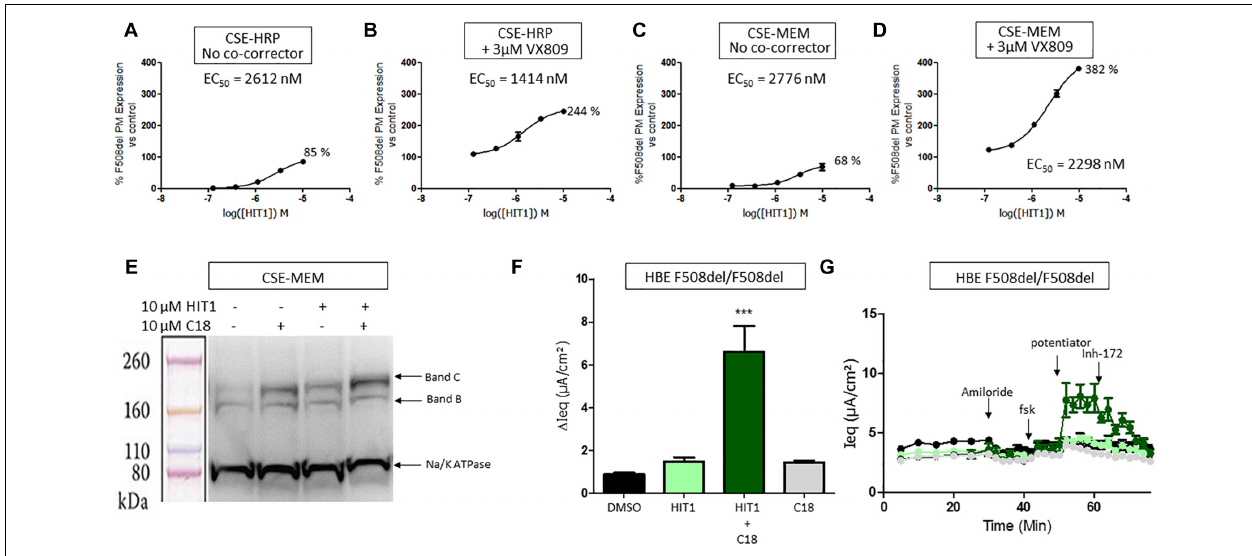
FIGURE 1 | Effect of HIT1 on F508del CFTR trafficking and function. (A) Dose response of 24 h treatment with HIT1 in CSE-HRP assay, % F508del CFTR expression at plasma membrane was normalized using VX809 correction as 100% in (A–D) and each concentration was tested in duplicate. (B) Dose–response of 24 h treatment with HIT1 in combination with 3 µ M VX809 in CSE-HRP assay. (C) Dose–response of 24 h treatment with HIT1 in CSE-MEM assay. (D) Dose–response of 24 h treatment with HIT1 in combination with 3 µ M VX809 in CSE-MEM assay. (E) CSE-MEM cells were incubated with compound for 24 h. Band C, mature complex-glycosylated F508del CFTR; Band B, immature core-glycosylated CFTR. (F) F508del/F508del HBE cells were incubated with compound for 24 h, CFTR channel was activated with 10 µ M forskolin and 3 µ M potentiator. ∗∗∗ denotes a p -value < 0.001 compared to DMSO treatment. (G) Average of raw traces of experiments represented in F ( n = 4 for each condition in F and G ).